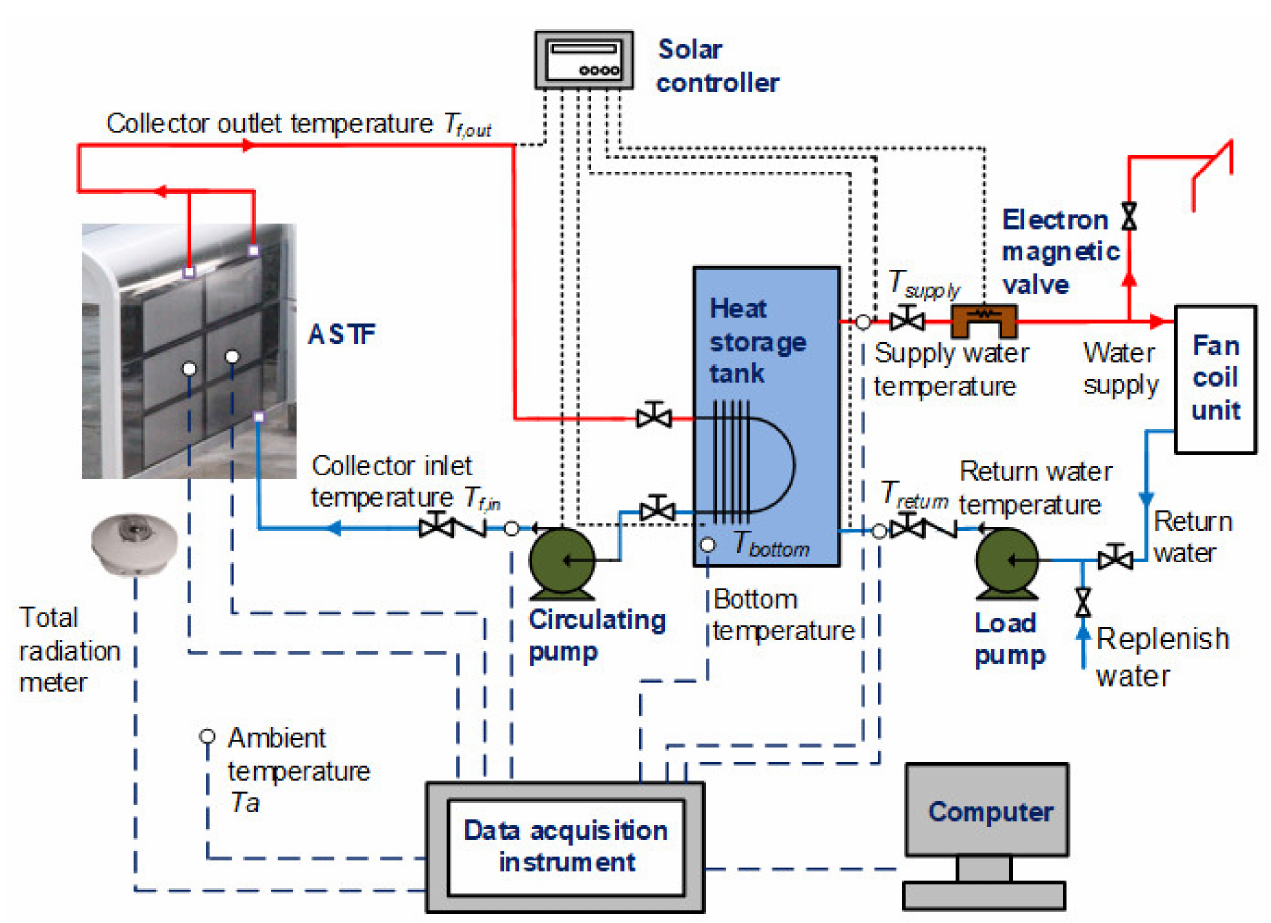
Figure 2. Schematic diagram of the ASTF